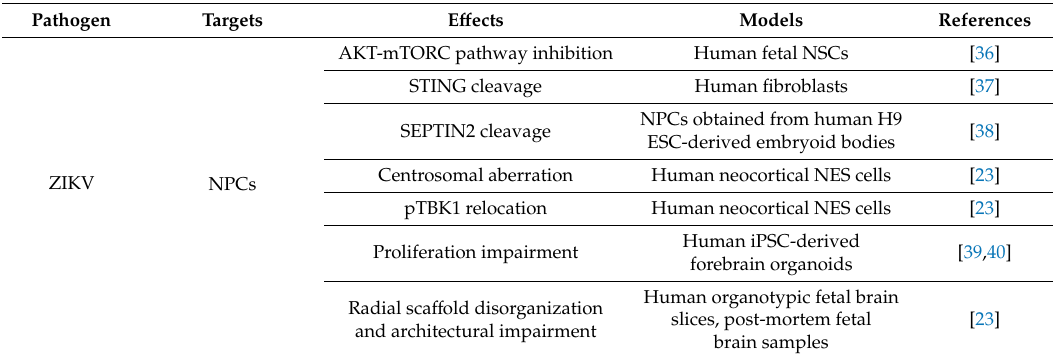
Table 1. Summary of the main studies addressing TORCH pathogens’ e ff ects on neural progenitor cells (NPCs), neural stem cells (NSCs), and their progeny. ER: endoplasmic